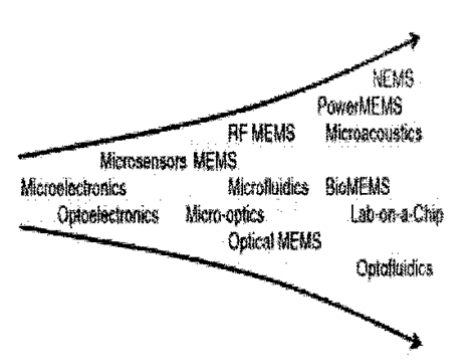
Figure 3. Defect images: (a) Bridging defects with low-resistance electrical behaviour on the top and high-resistance electrical behaviour on the bottom microphotograph, and (b) Open defect inside the circle [20].